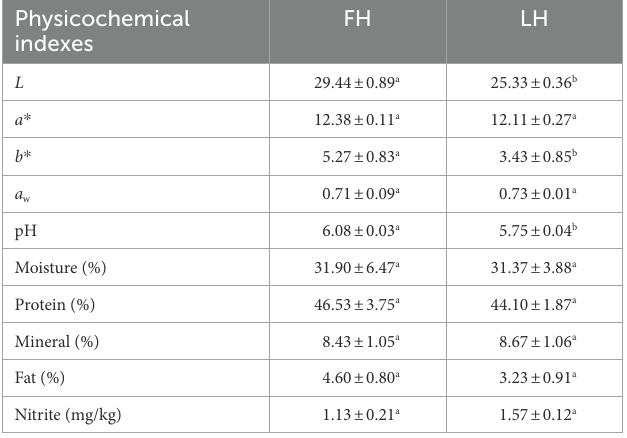
TABLE 1 Physicochemical parameters of internal samples from Jinhua FH and LH. Physicochemical